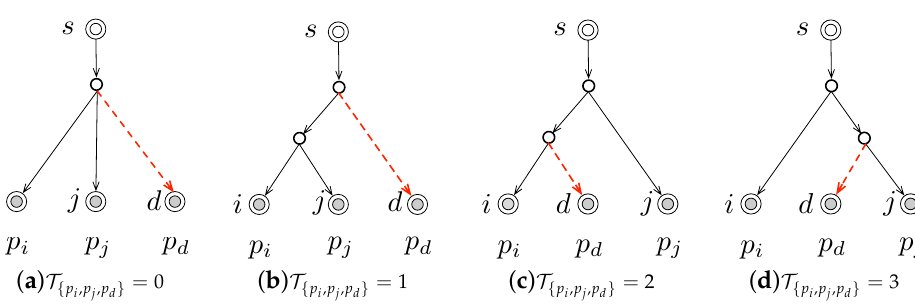
Figure 2. The four different kinds of three-path-based